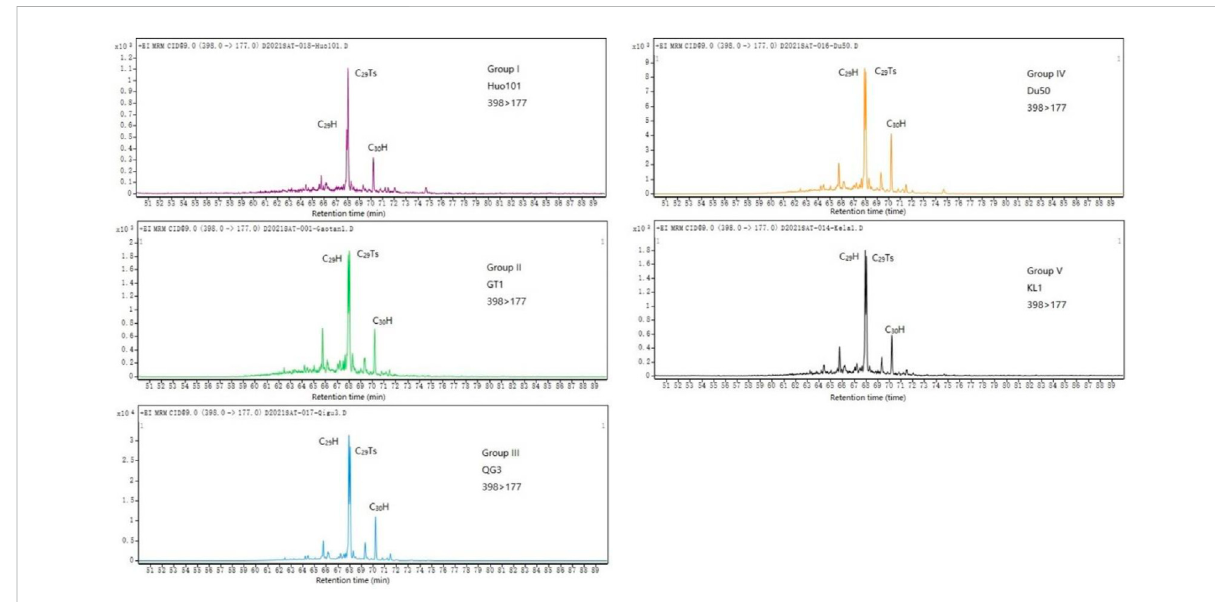
FIGURE 6 MRM chromatograms showing absence of 25-norhopanes in representative Group I – V oils. The abbreviations of compound names see Figure